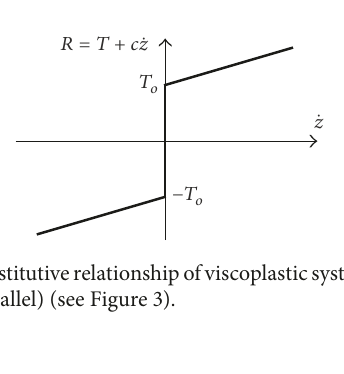
Figure 4: Constitutive relationship of frictional element (slider).